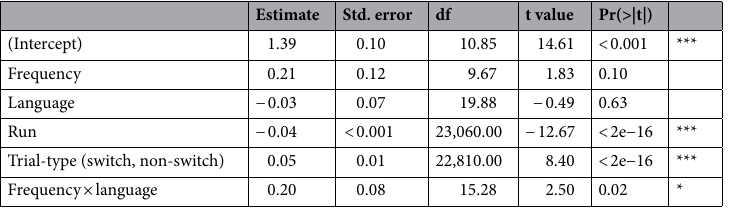
Table 5. Results from linear mixed effect models predicting reaction time for color